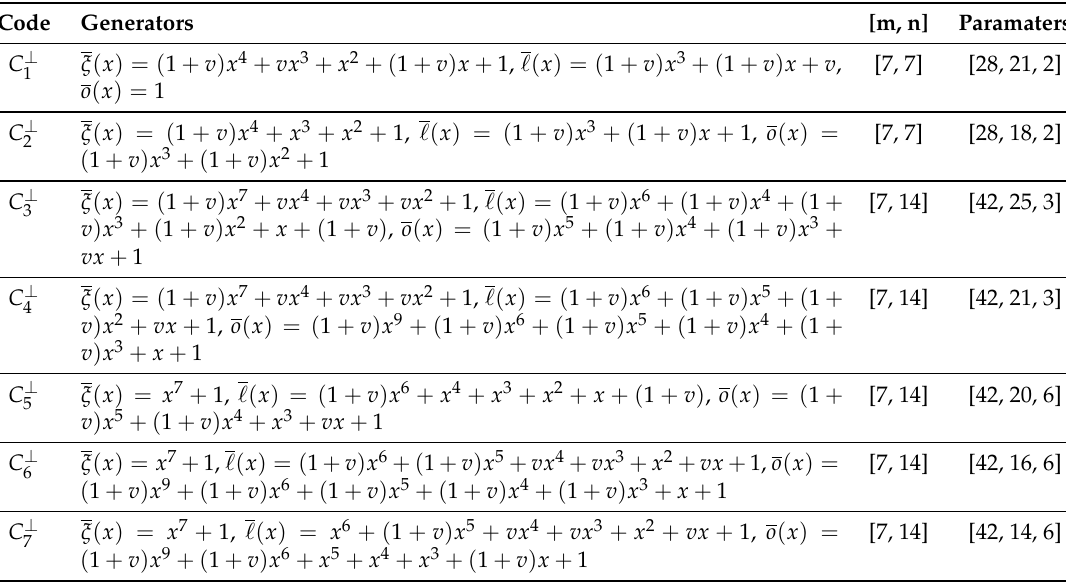
Table 3. The dual codes of Table